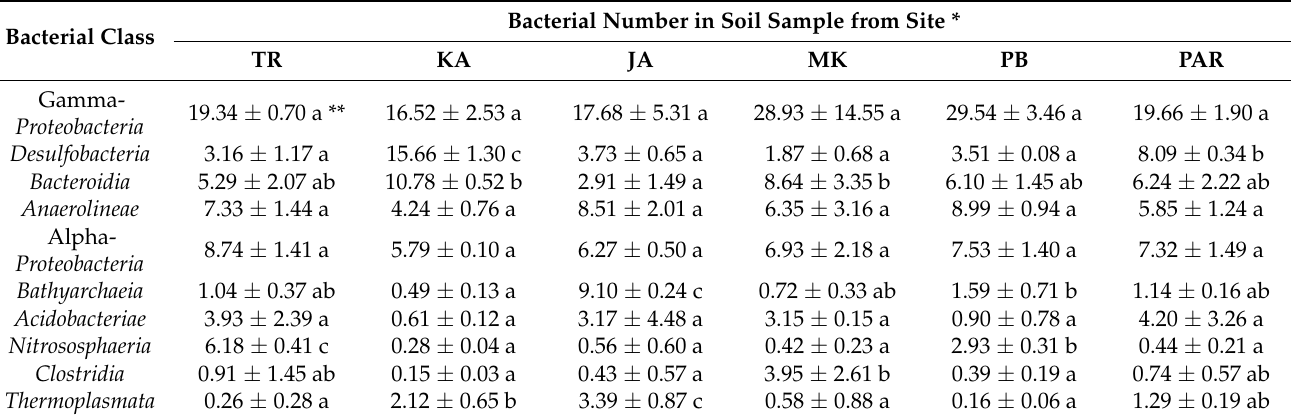
Table 6. Percentages of OTUs of top ten most abundant bacterial classes present in each sampling